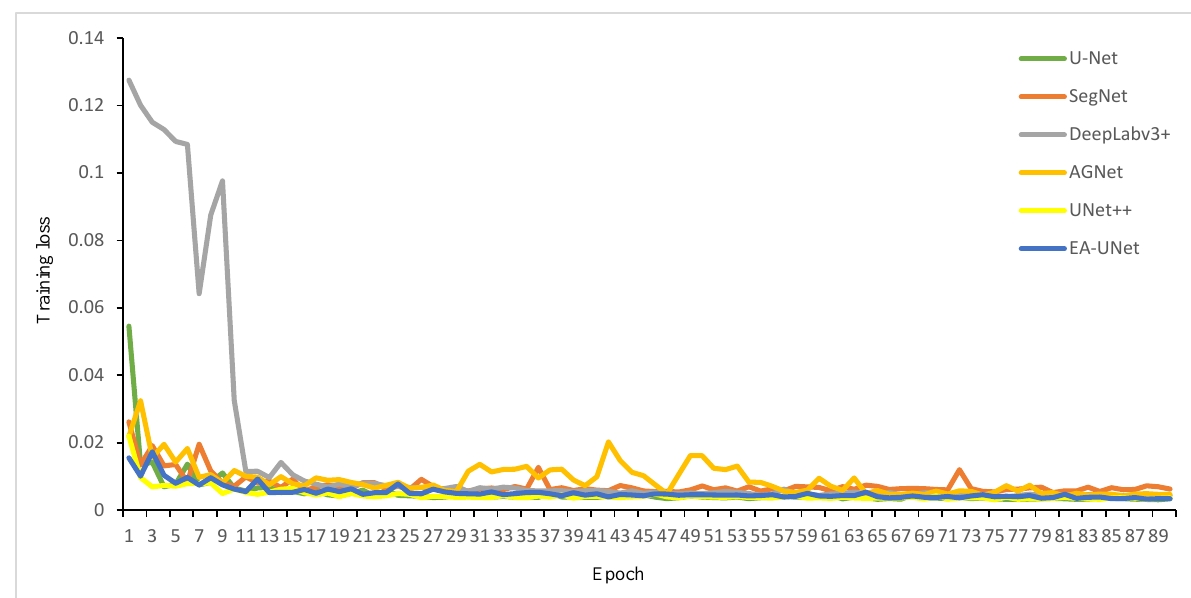
Figure 8. Comparison of change of loss function for different methods.